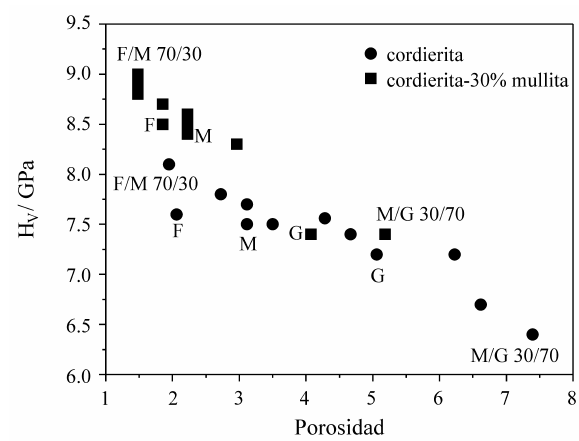
Figura 1. Variación de la dureza Vickers (H V ) de los materiales de cordierita y cordierita-30% mullita con la porosidad.